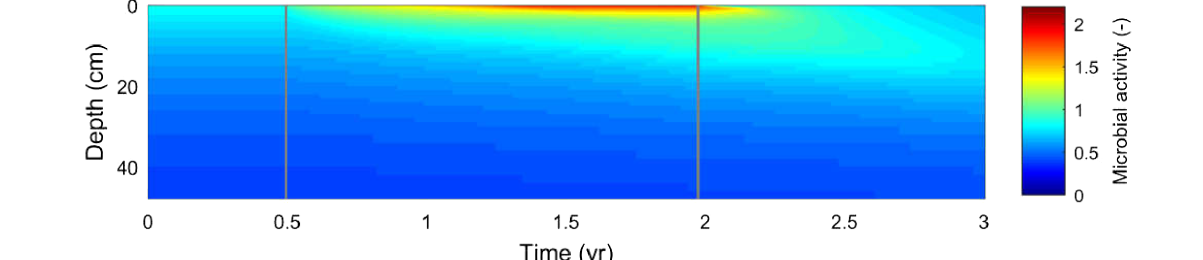
Fig. 4. Microbial activity (dimensionless) in sediments exposed to organic enrichments according to parameters of Table 2 and assuming a feed wastage of 3%. Vertical lines at 0.5 and 1.97 yr delineate the farming cycle. This simulation